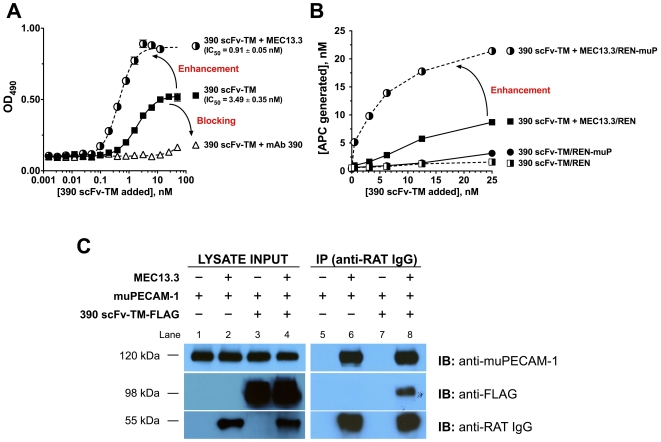
In vitro enhancement of binding, accessibility and therapeutic output of anti-PECAM-1 390 scFv-TM fusion protein via dual epitope-engagement of muPECAM-1.(A) Cell surface binding of the therapeutic fusion protein 390 scFv-TM to REN-muP cells was assessed in the presence of 200 nM self-paired parental mAb 390 or paired mAb MEC13.3 by ELISA. The curves shown are representative ELISA. Only binding to REN-muP cells shown; there was no significant binding detected using control REN cells lacking muPECAM-1. Binding affinity of 390 scFv-TM, reflected by IC50, increases 3.8−fold when paired with MEC13.3. The IC50 is reported as the mean IC50 value ± SD of three independent experiments performed in triplicate. (B) Generation of activated protein c (APC), a cell-protective species, on the surface of REN-muP cells is initiated by targeted binding of 390 scFv-TM (+thrombin). APC generation is augmented up to 5−fold when 390 scFv-TM binding is enhanced with paired mAb MEC13.3 compared to 390 scFv-TM alone. (C) Co-IP of the MEC13.3/muPECAM-1/390 scFv-TM-FLAG complex in REN-muP cells. REN-muP cells were treated with muPECAM-1 targeted rat anti-mouse IgG MEC13.3 and anti-mouse 390 scFv-TM-FLAG combinations. Cell lysates were immunoprecipitated with Protein G agarose beads to MEC13.3 and analyzed by SDS-PAGE and immunoblotting (IB) using anti-muPECAM-1, anti-FLAG, and rat polyclonal anti-mouse antibodies, as described under “Methods.” For controls, REN-muP cells ±390 scFv-TM FLAG were incubated with Protein G beads alone (lanes 1 and 5, 3 and 7). 390 scFv-TM-FLAG was only detected in the IP for REN-muP cells co-treated with MEC13.3 and 390 scFv-TM-FLAG (lane 6), indicating an interaction between MEC13.3 and 390 scFv-TM through muPECAM-1. Data are representative of two independent experiments.